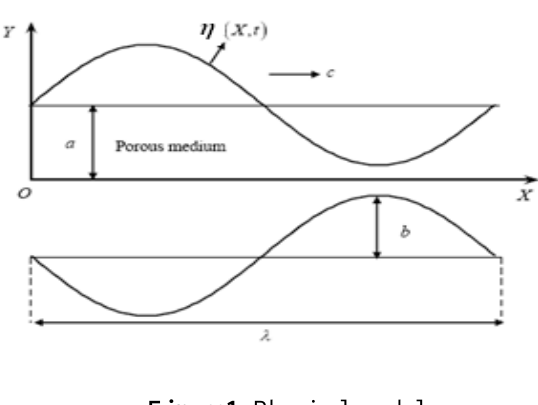
Figure1. Physical